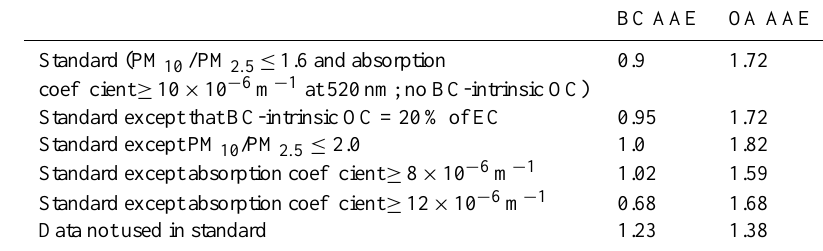
Table 4. Sensitivity of estimated AAE. In a sensitivity experiment where BC contains OC, OA MAC refers to OA absorption cross section divided by the carbon mass in OC (i.e. OC in OA+BC-intrinsic OC). AAE is computed using MAC at all of the 7